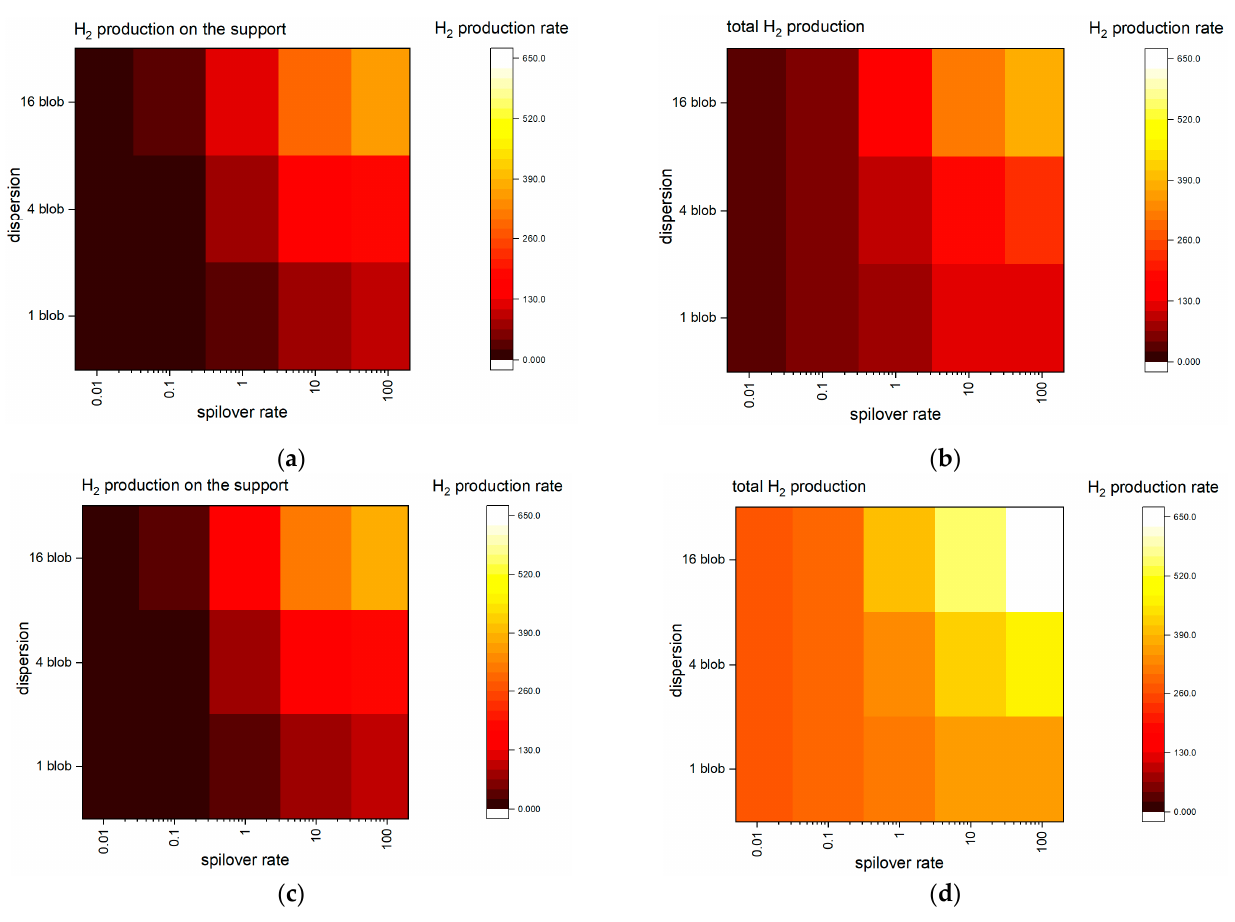
Figure 1. Heatmaps for H 2 production when the Heyrovsky reaction is slow as a function of catalyst dispersion and the spillover rate: ( a ) production from the support for the C@S configuration; ( b ) total production for the C@S configuration; ( c ) production from the support for the S@C configuration; ( d ) total production for the S@C configuration.